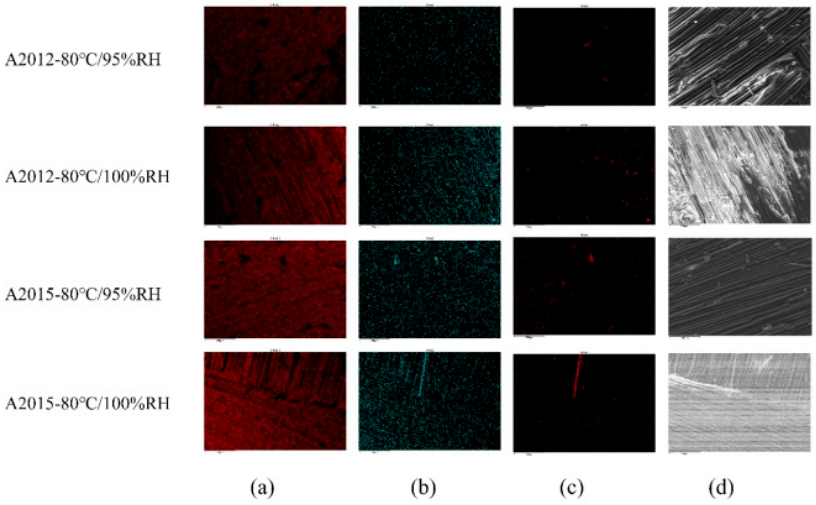
Figure 14. EDX under different environments and adhesives for 30 days: ( a ) C element, ( b ) O element, ( c ) Si element, and ( d ) electronic image. Table 4. Different element content in EDX.